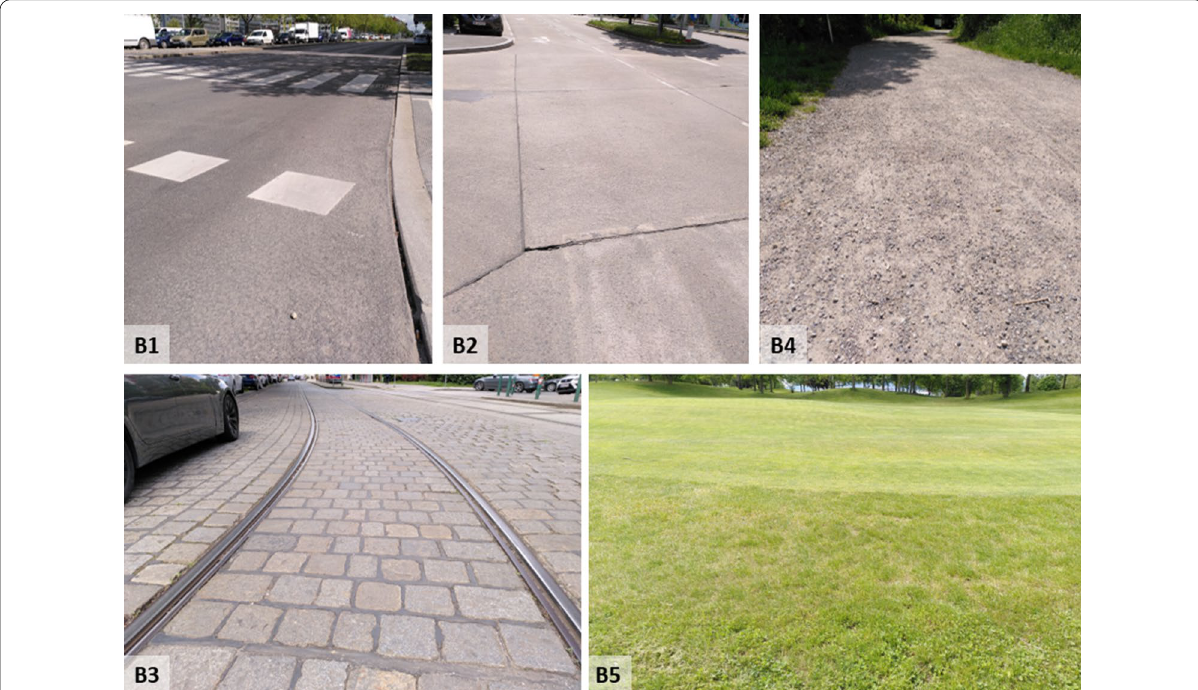
Fig. 3 Typical Viennese ground surfaces for the implementation in uhiSolver: B1 path, B5 =